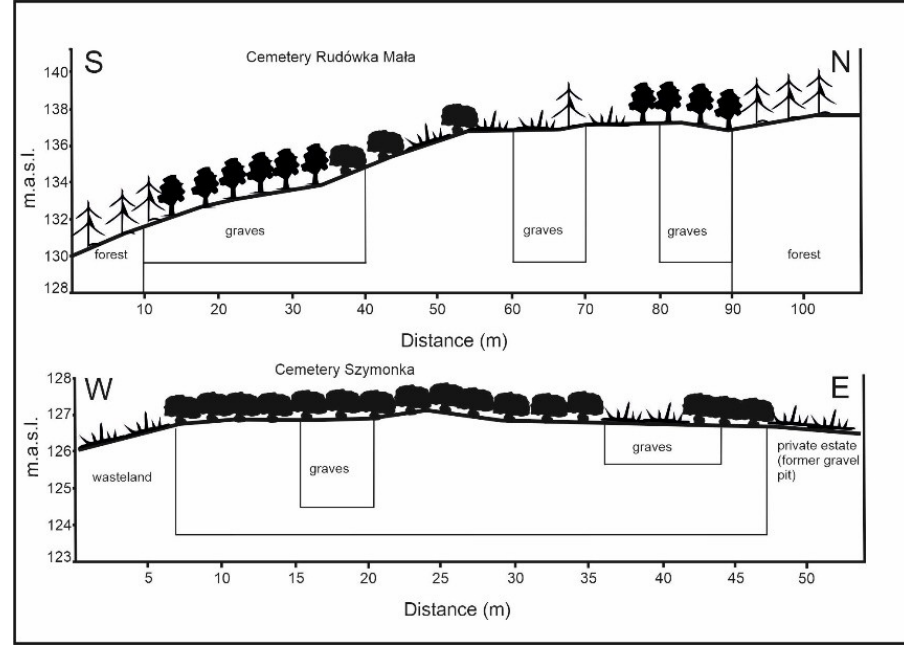
Figure 2. Locations of the examined cemeteries against the background of landform.